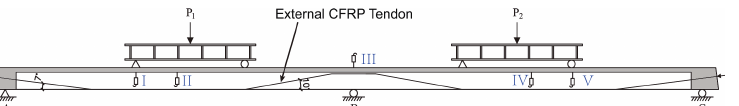
Figure 1. Two-span continuous concrete T-beams: I is the control section of AB, II is the mid-span section of AB, III is the mid-span section of the beam, IV is the mid-span section of BC, and V is the control section of BC